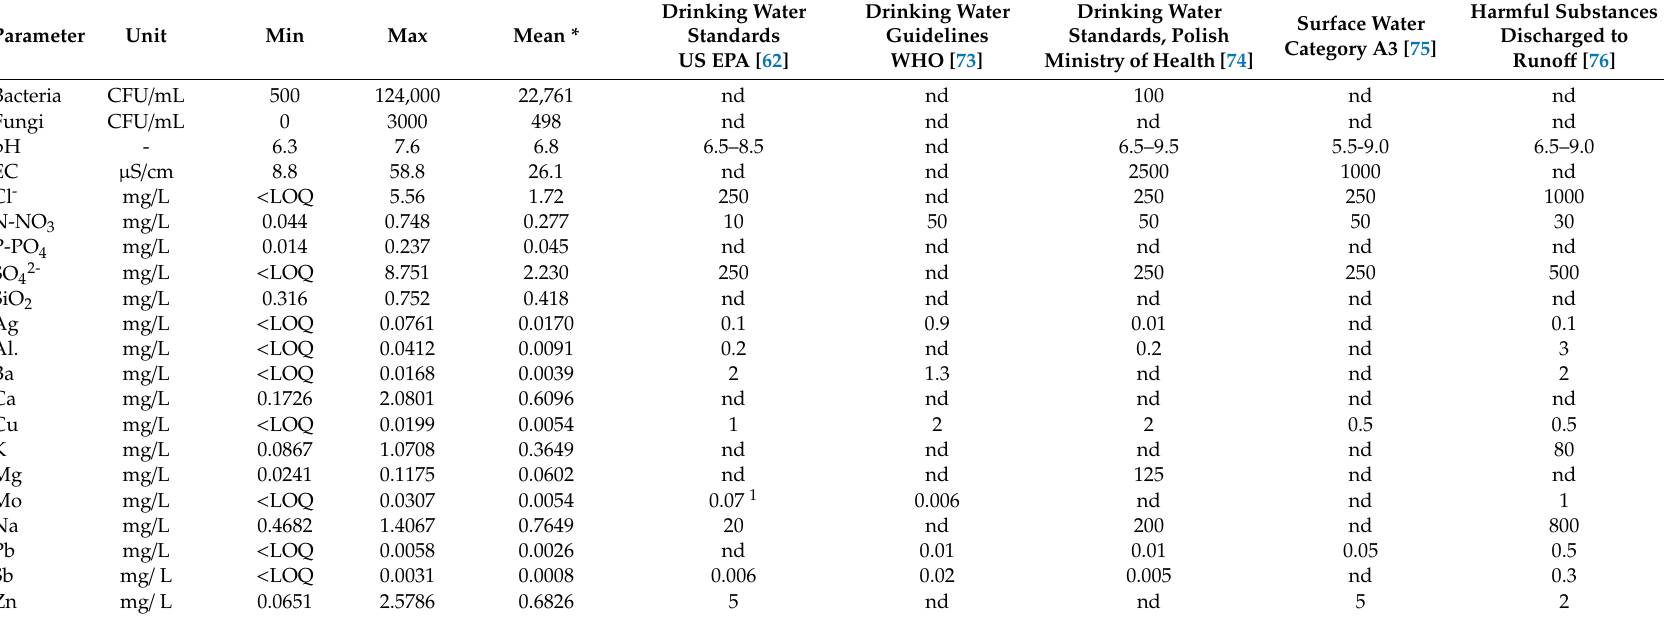
Table 1. Statistical parameters, and permissible levels of the selected elements in the roof runo ff samples, investigated in Krak ó w (KR1-KR5) in 2019 / 2020